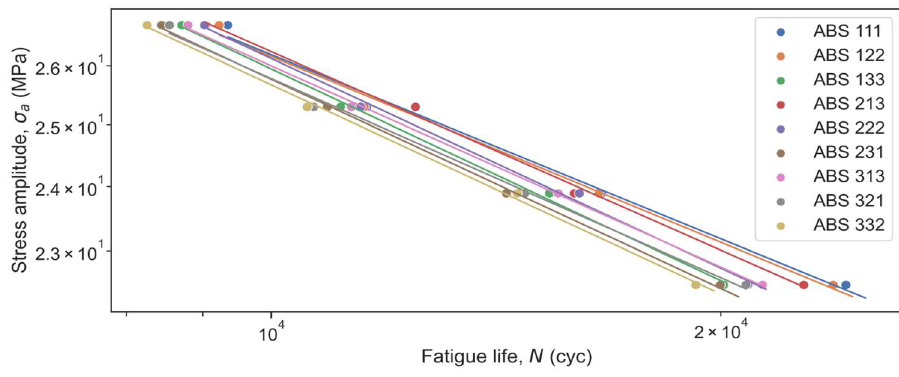
Figure 5. Experimental S-N curve for ABS.